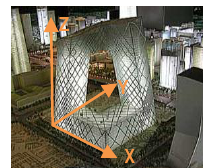
Figure 2. Reference system adopted